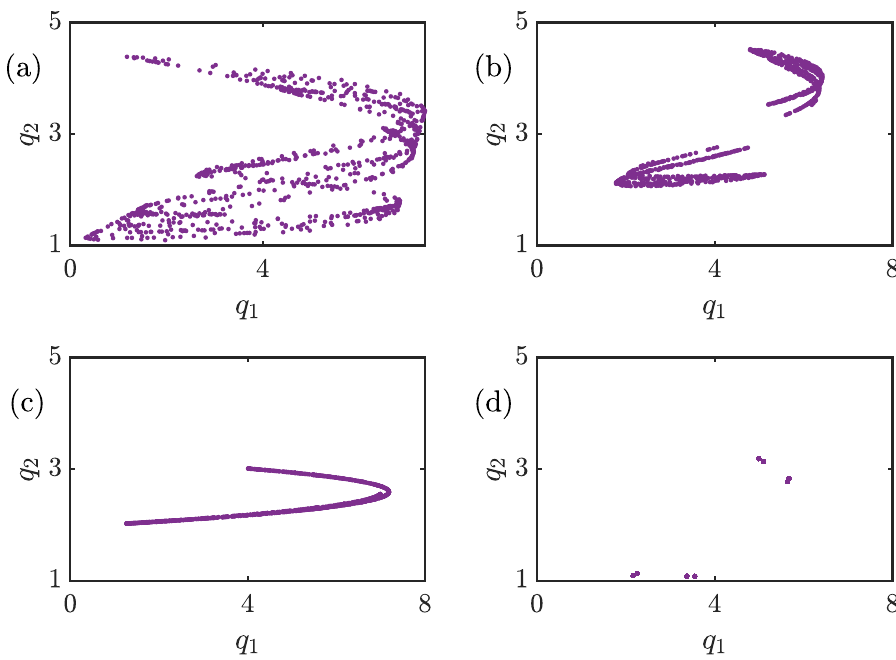
Fig 2. Periodic and chaotic attractors of Eq (13) on the q 1 − q 2 plane with c 1 = 2, c 2 = 1, d 1 = 0.5, v 1 = 0.1 and initial conditions q 1 (0) = q 2 (0) = 1. (a) Strange attractor with a = 6, b = 0.5, d 2 = 1, and v 2 = 1.6, (b) Strange attractor with a = 6, b = 0.5, d 2 = 0.5, and v 2 = 1.6, (c) Strange attractor with a = 6, b = 0.5, d 2 = 1, and v 2 = 1, and (d) Period-8 attractor with a = 6, b = 0.6, d 2 = 1, and v 2 = 1.6. This model can not only exhibit various chaotic attractors but also can lead to periodic